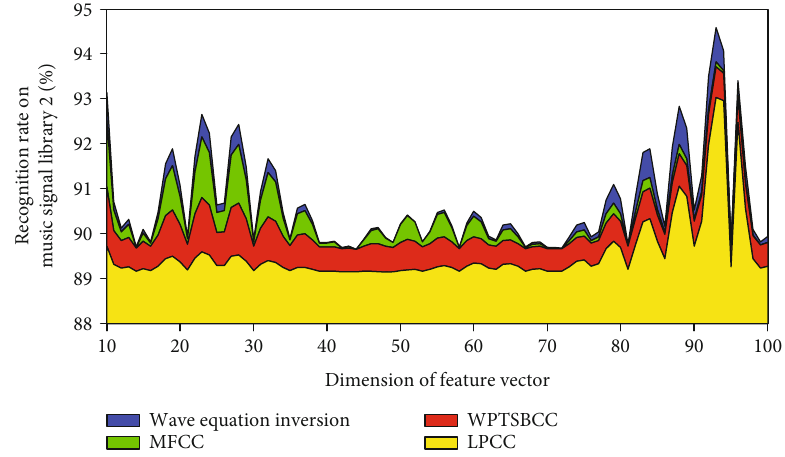
Figure 8: The recognition rate of di ff erent feature vector dimensions on the music signal library 2.